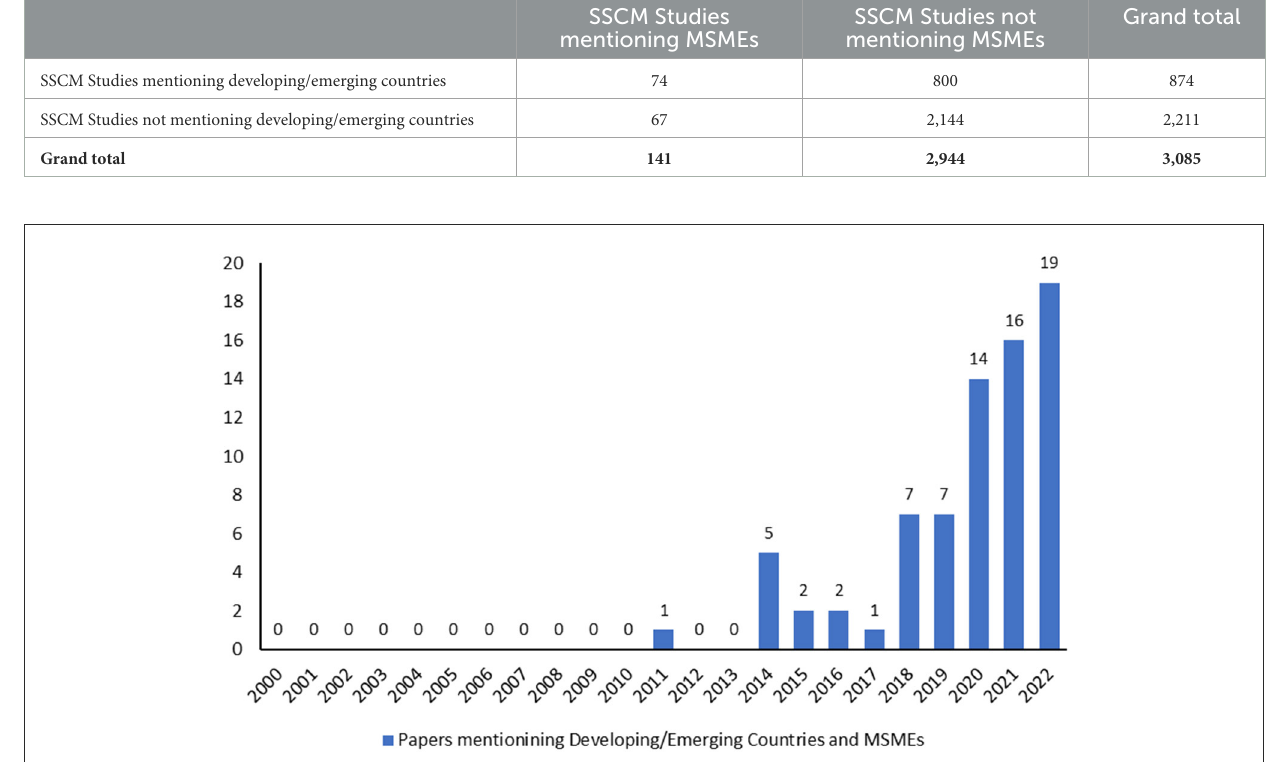
FIGURE10 Annual Growth Trajectory of Literature on SSCM, mentioning both MSMEs and developing countries in the same